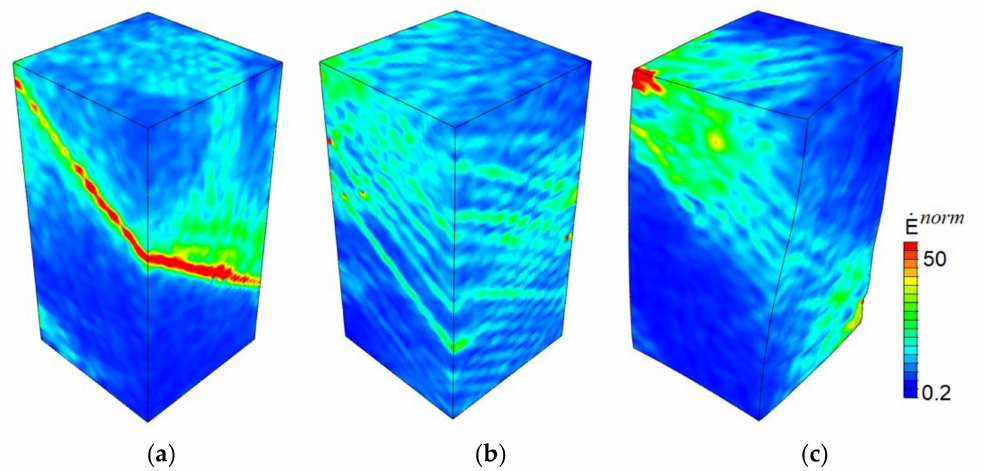
Figure 9. Normalized strain rates in a single crystal with the {110} lateral faces compressed along the [001] axis in three stages of plastic deformation for compressive strains of 0.005 ( a ), 0.02 ( b ), and 0.06 ( c ). Video S3 is available online in Supplementary Materials.